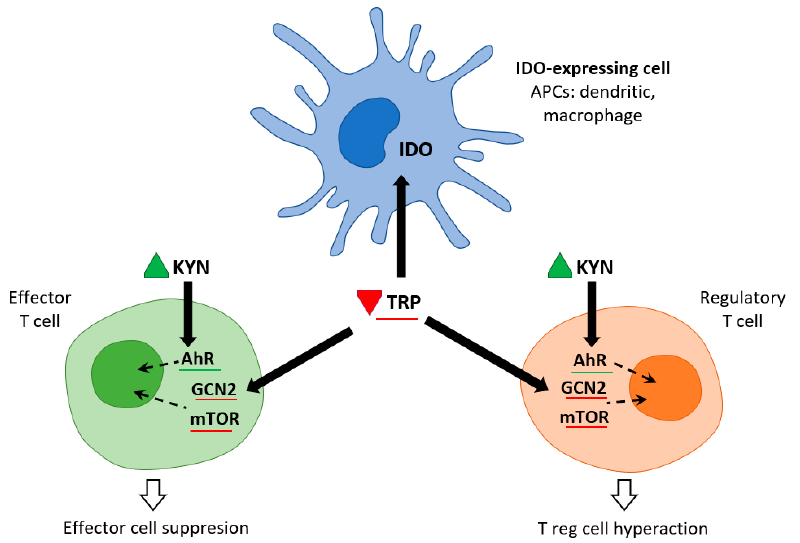
Figure 2. IDO and metabolic control of inflammation (adapted from [6]). IDO activity in APCs leads to Kyn release and Trp consumption. These metabolic signals affect both effector T cells and Treg cells via AhR (Kyn release) and the amino-acid sensors GCN2 and mTOR (Trp consumption), which in turn leads to immune suppression and tolerance.